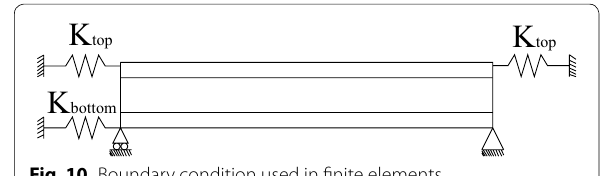
Fig. 10 Boundary condition used in finite elements.